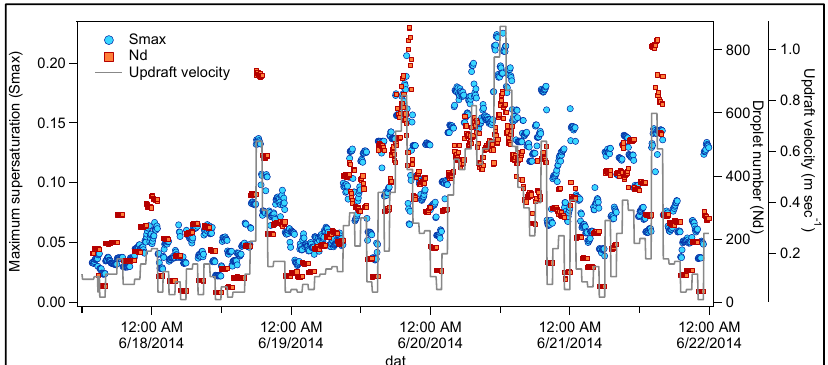
Figure 3. Calculated maximum supersaturation and droplet number with regard to the updraft velocity, during the measurement period.